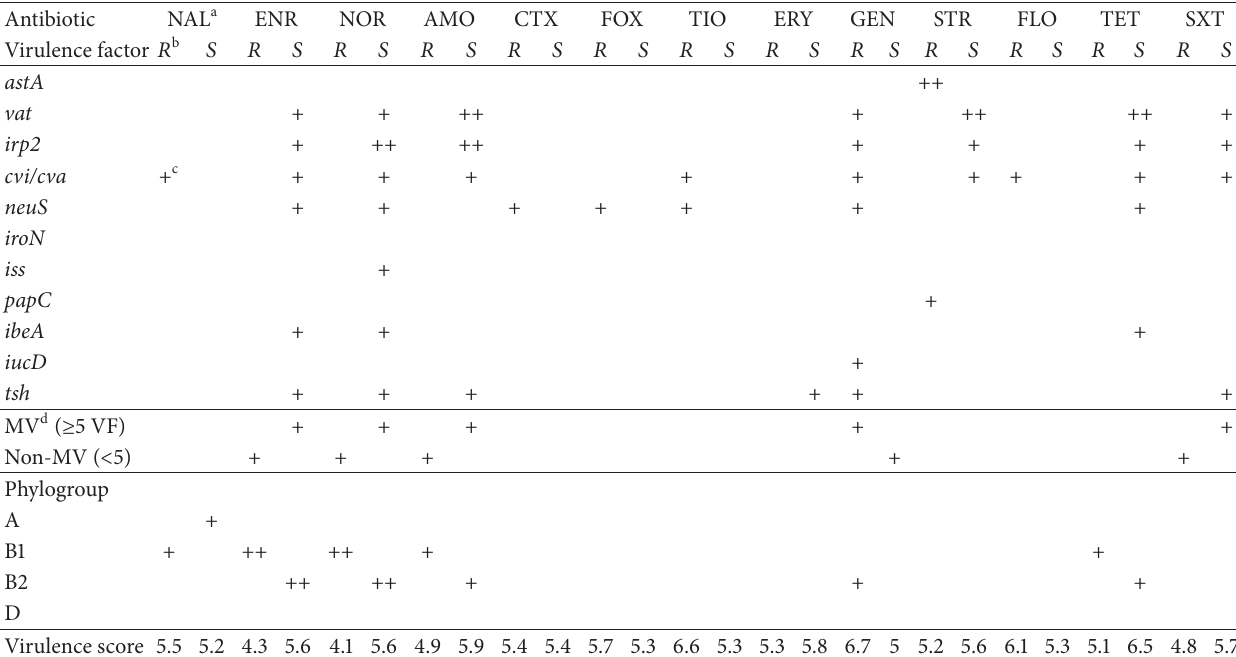
Table 3: Distribution of virulence genes and phylogenetic groups in relation to antibiotic resistance phenotypes among 225 ExPEC isolates. Antibiotic NAL